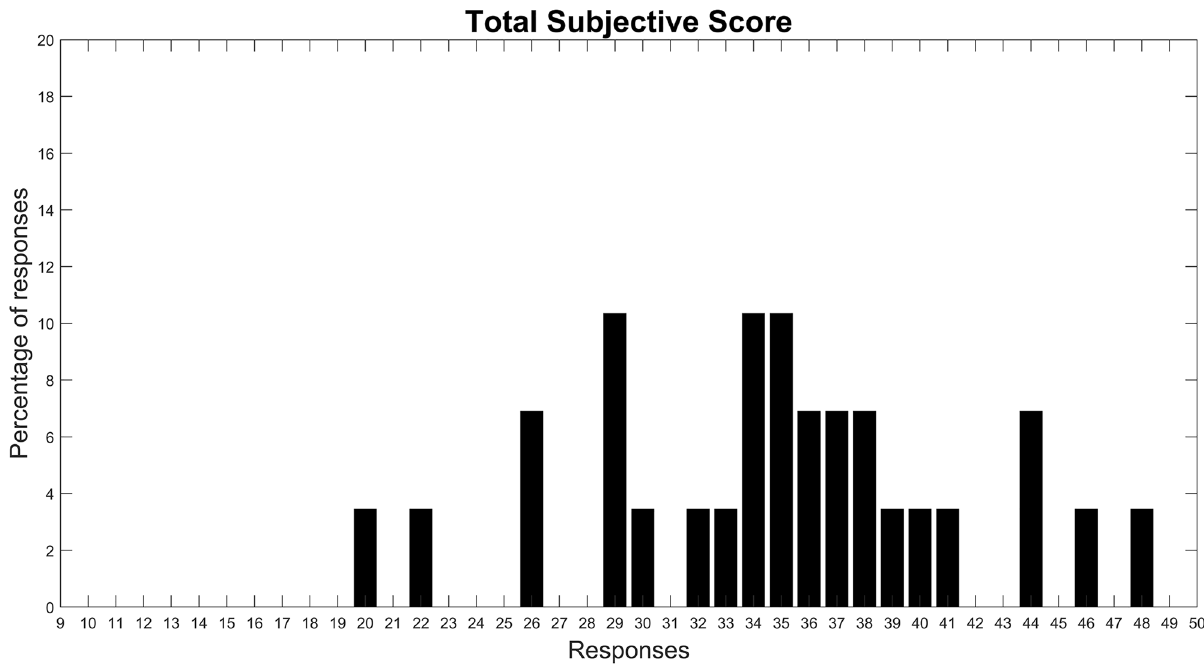
Figure 3. Histogram displaying the Total Subjective Score distribution (from TSSmin = 9 to TSSmax = 50).